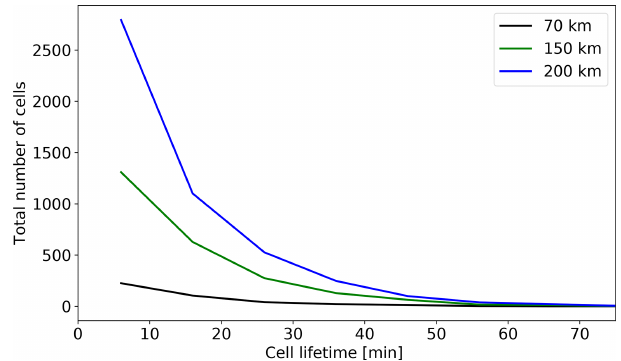
Figure 13. Number of isolated cells that both initiated and dissi- pated with 70, 150, and 200km of the KHGX radar as a function of cell lifetime during June through September of 2015–2017. Inte- grated totals are 441, 2442, and 4843,